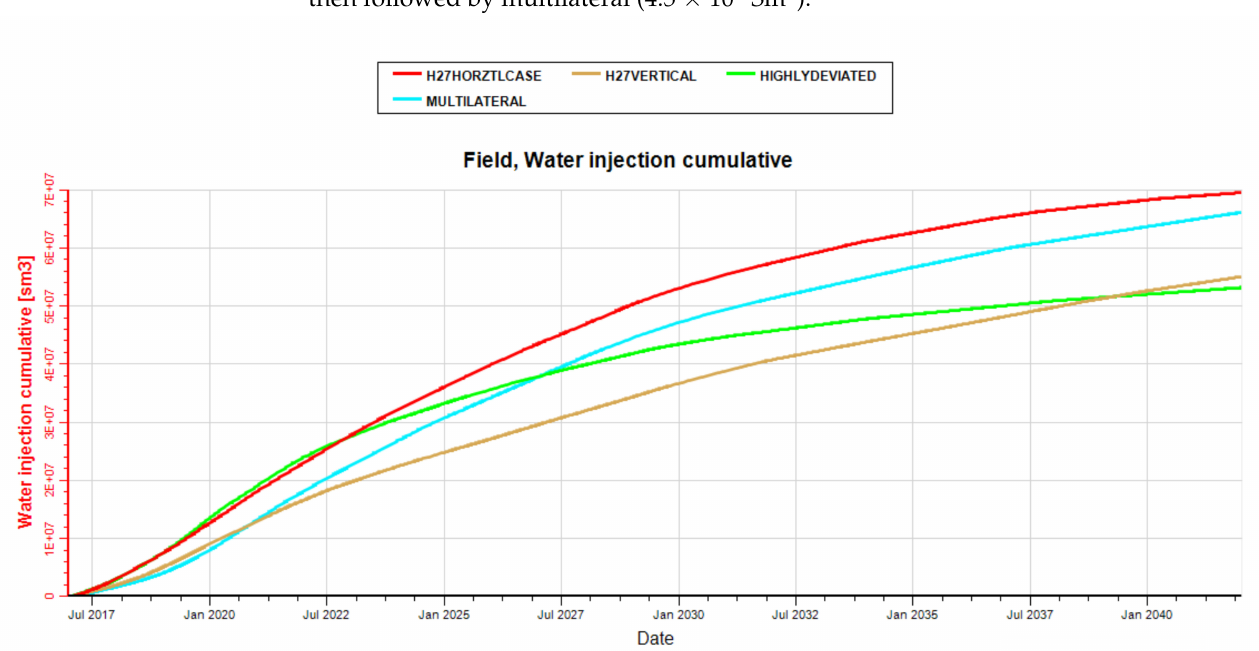
Figure 14. Field water production cumulative for each well